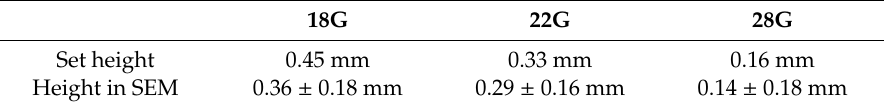
Figure 4. SEM images of a printed cylinder. ( A ) View of the external surface of the cylinder, showing integrity with clear boundaries. ( B ) Interior surface of cylinder wall showing the presence of porous microstructure clearly visible in the inset, which is a magnification of the region bounded by the white rectangle. ( C ) View of the vertical cross section of the cylinder. Arrows show the regions of fusion between layers. Table 3. The set layer height in printing and the layer height obtained from SEM (n = 3).